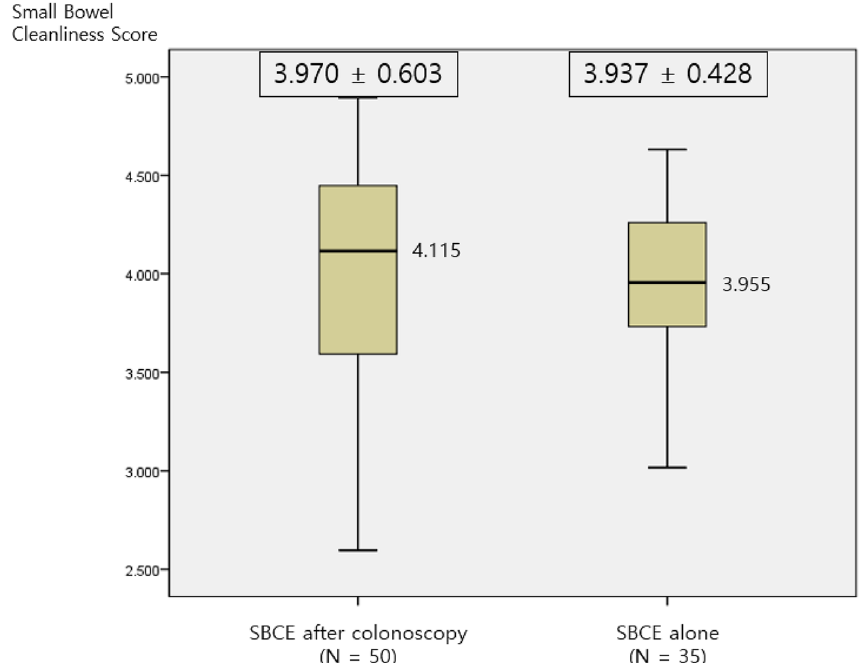
Figure 1. Relationship between small bowel cleanliness score and pre-colonoscopy. The mean small bowel cleanliness score in small bowel capsule endoscopy (SBCE) immediately after colonoscopy was 3.970 ± 0.603, and in SBCE alone was 3.937 ± 0.428. There was no significant difference between the colonoscopy and small bowel cleanliness score (p = 0.785).